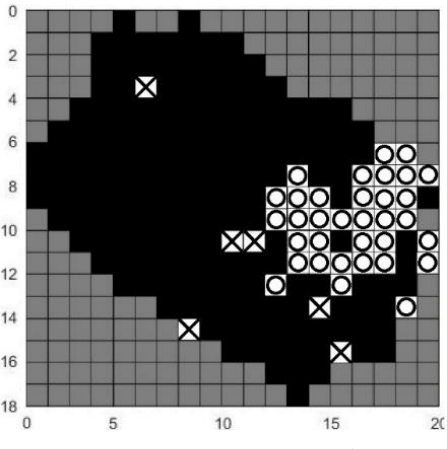
Figure 8. Benggang recognition labels of our method